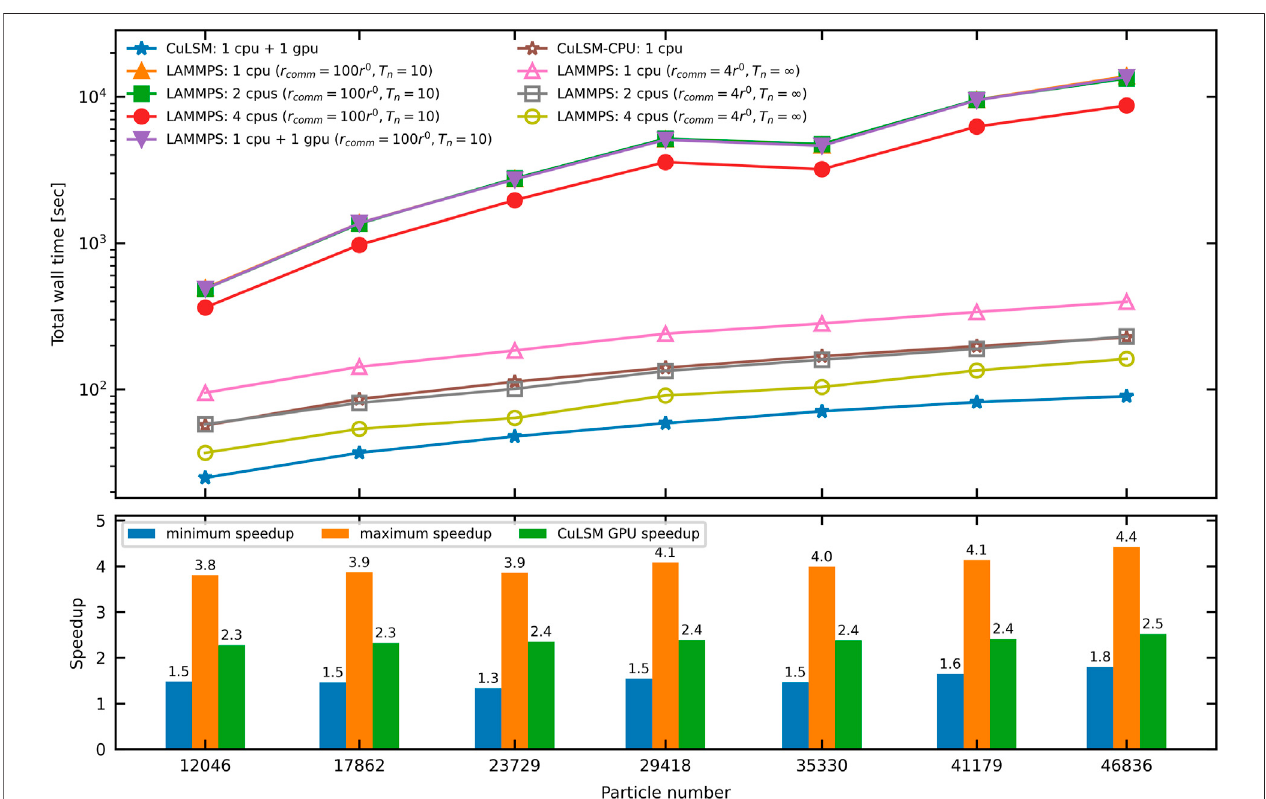
FIGURE 7 | Comparison of the total computing wall time by CuLSM and LAMMPS. The insets enlarge the regions around LAMMPS: 1 CPU, LAMMPS: 2 CPUs, and LAMMPS: 1 CPU + 1 GPU. Note that LAMMPS: 1 CPU + 1 GPU does not support parallelism on spring list. The maximum and minimum speedup of CuLSM compared with other four models are illustrated in the bottom